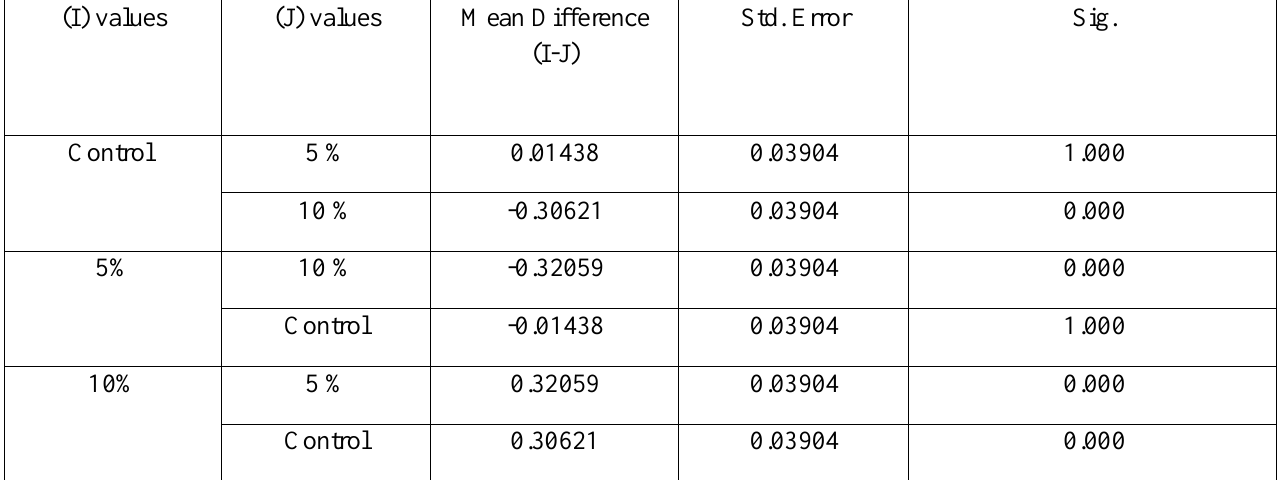
Table 8: Post HOC test between groups of water sorption test (mg/cm 2 )